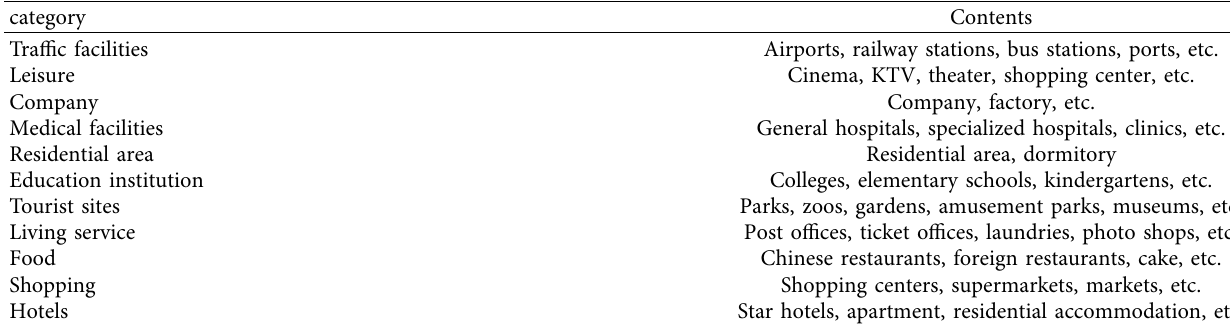
Table 2: POI category